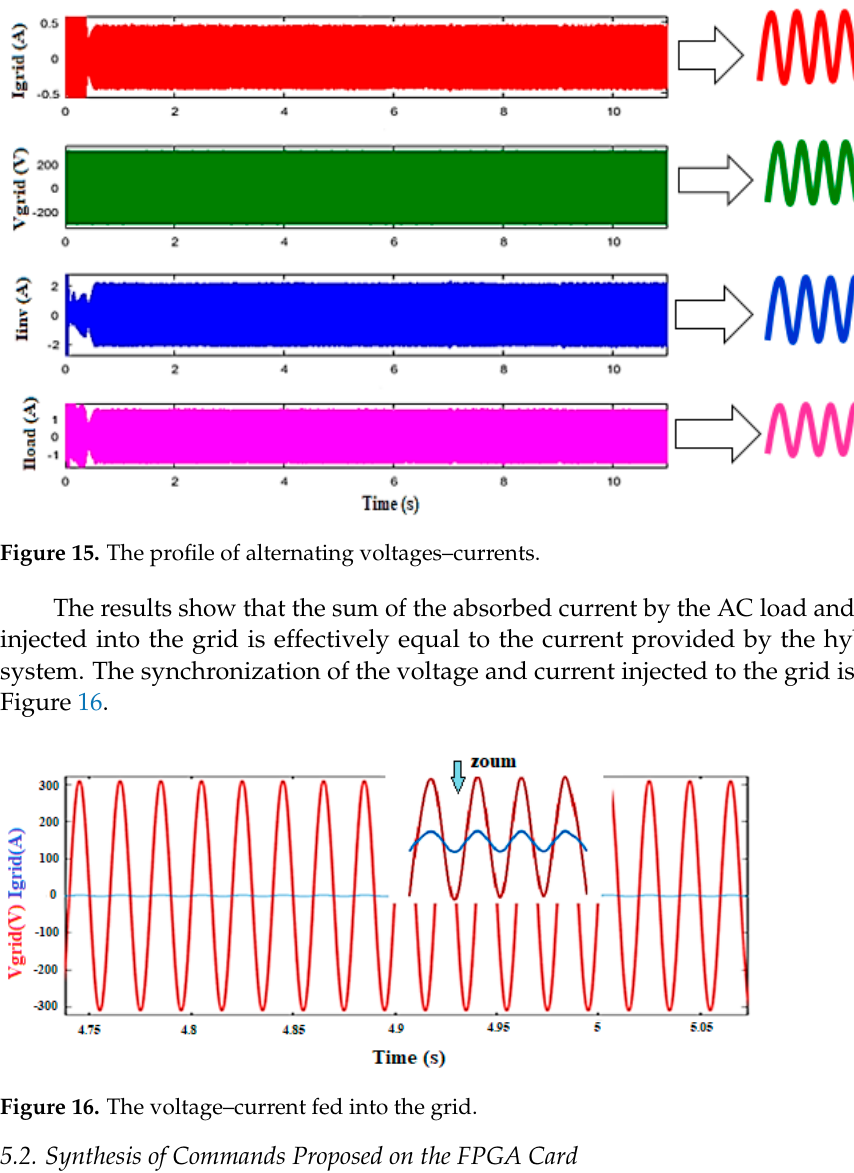
Figure 14. Waveforms of the output current ( a ), voltage ( b ), and power ( c ) of the DC-DC high gain converter.